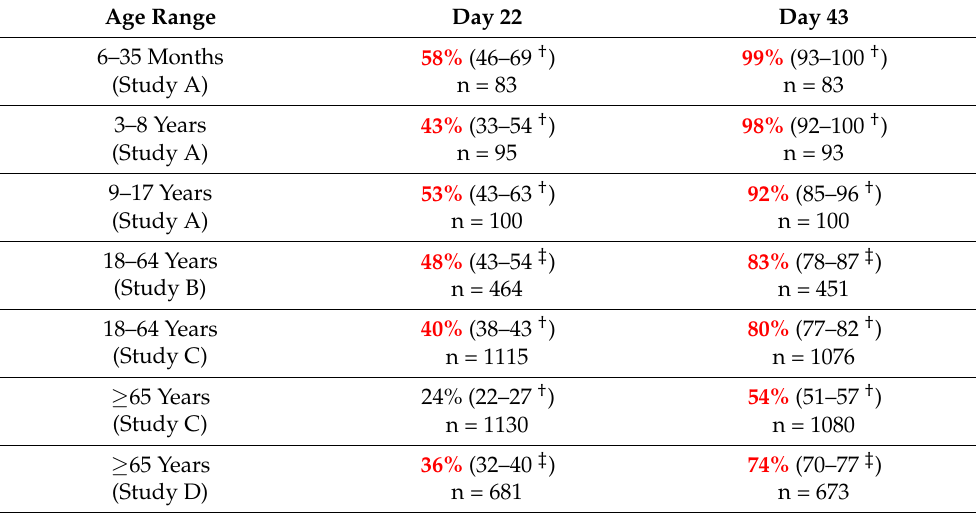
Table 2. Percentages (95% † or 97.5% ‡ CI) of subjects achieving seroconversion in response to full-dose formulation, as assessed by hemagglutination inhibition assay three weeks after first dose (Day 22), and three weeks after second dose (Day 43) administration.